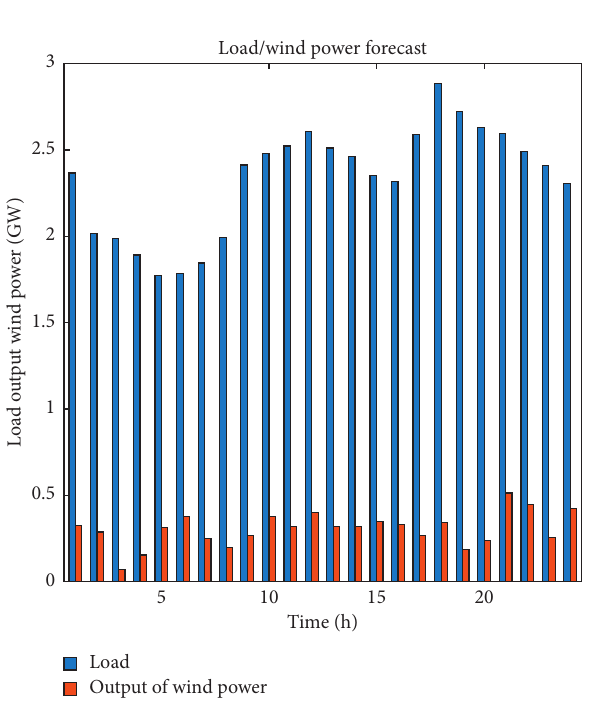
Figure 3: Load and wind power